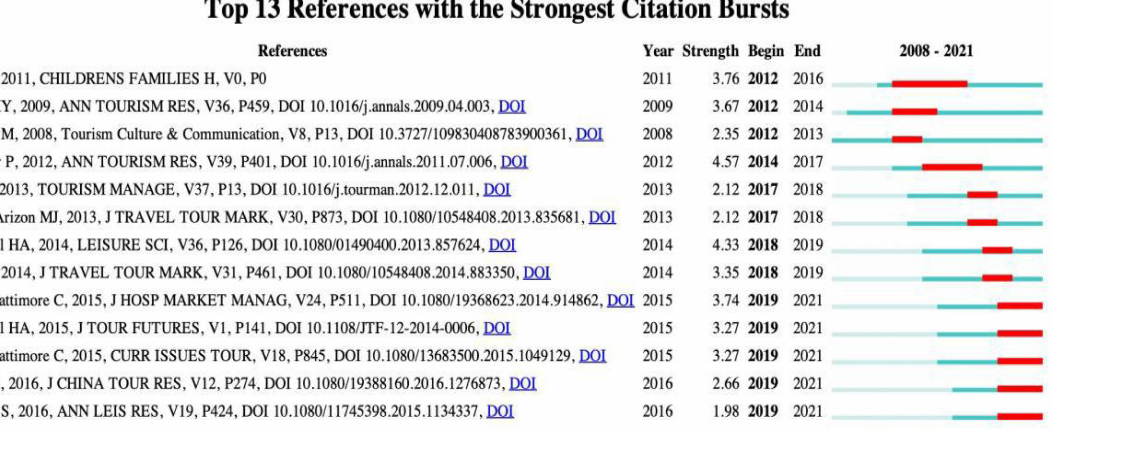
FIGURE 7 | Top references with the strongest citations